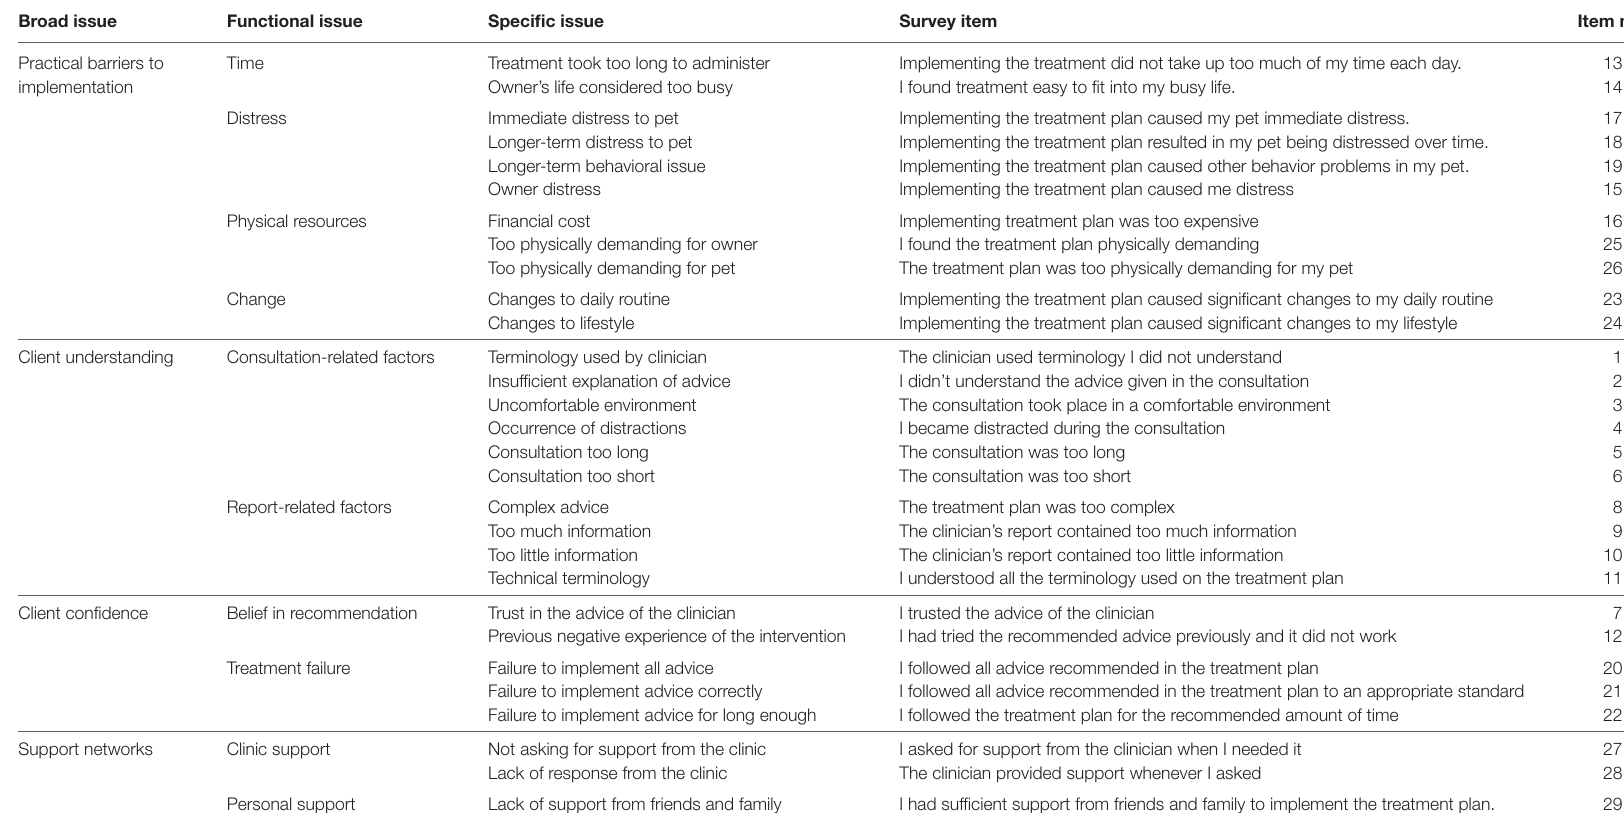
TaBle 2 | Organization of factors associated with nonadherence to advice given at behavior consultation including related Lincoln Adherence Instrument Record survey items. Broad